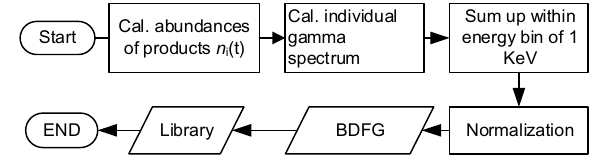
Fig. 1. The main flow of FP.pl